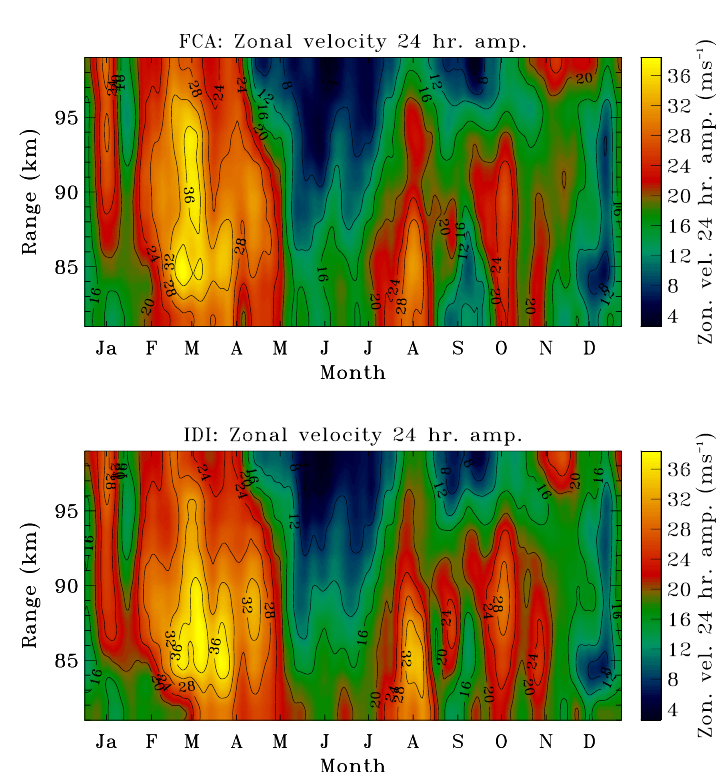
Fig. 8. Annually superposed FCA/IDI zonal winds diurnal